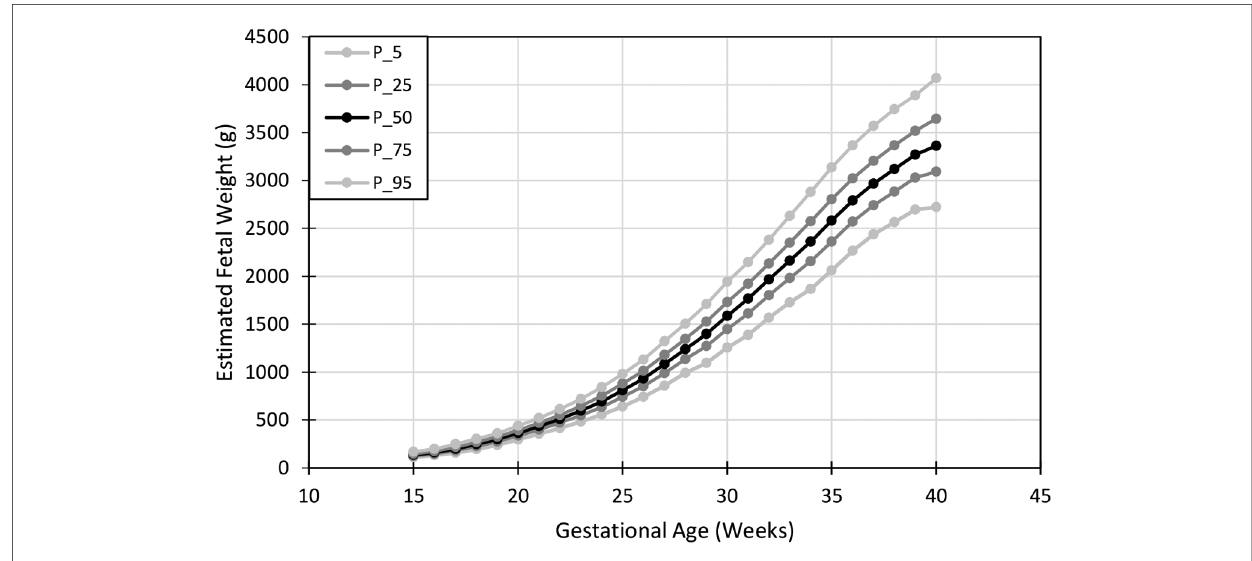
FIGURE 3 Local fetal growth reference curve for estimated fetal weight using LMS